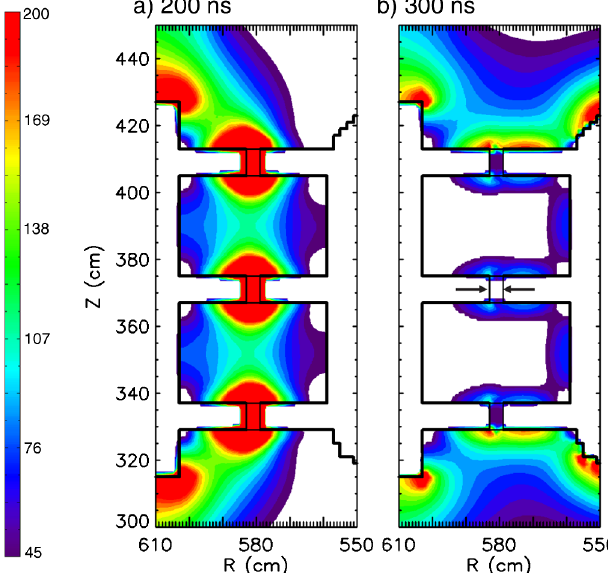
FIG. 9. (Color) Electric-field magnitude in the upper module water switches in the (cid:2) ¼ 0 plane at 200 and 300 ns. The arrows indicate the location of the conductivity channel in the switch.